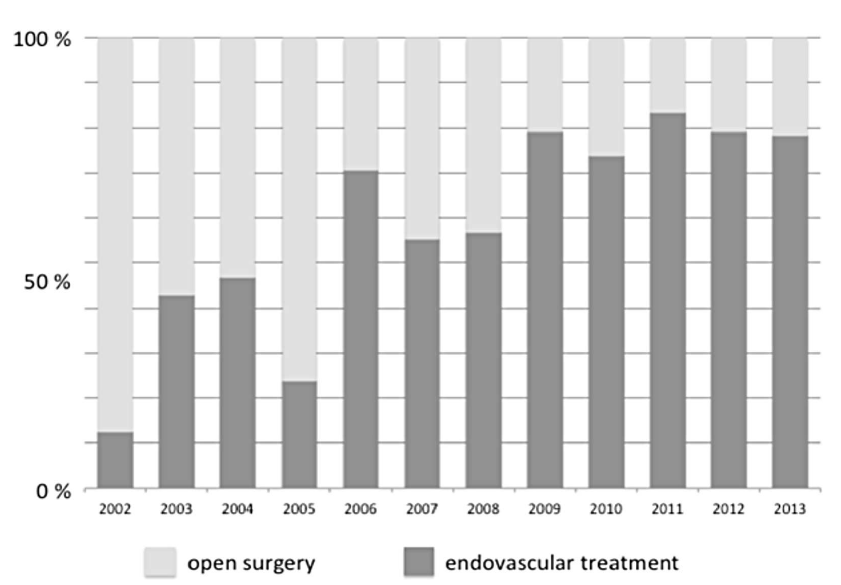
Fig 2. Development of endovascular and open surgical treatment of BTAI in Germany from 2002 till 2013.